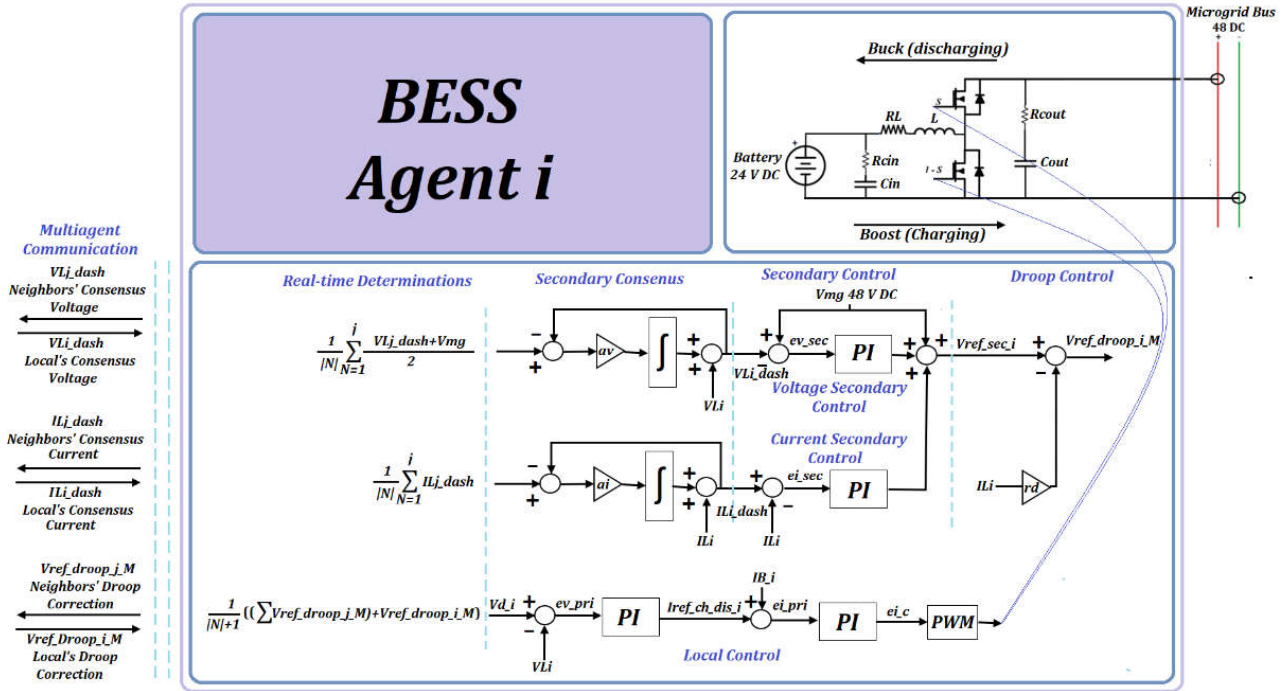
Figure 9. The adapted multiagent primary–secondary consensus control of BESS agents in DC autonomous microgrid.